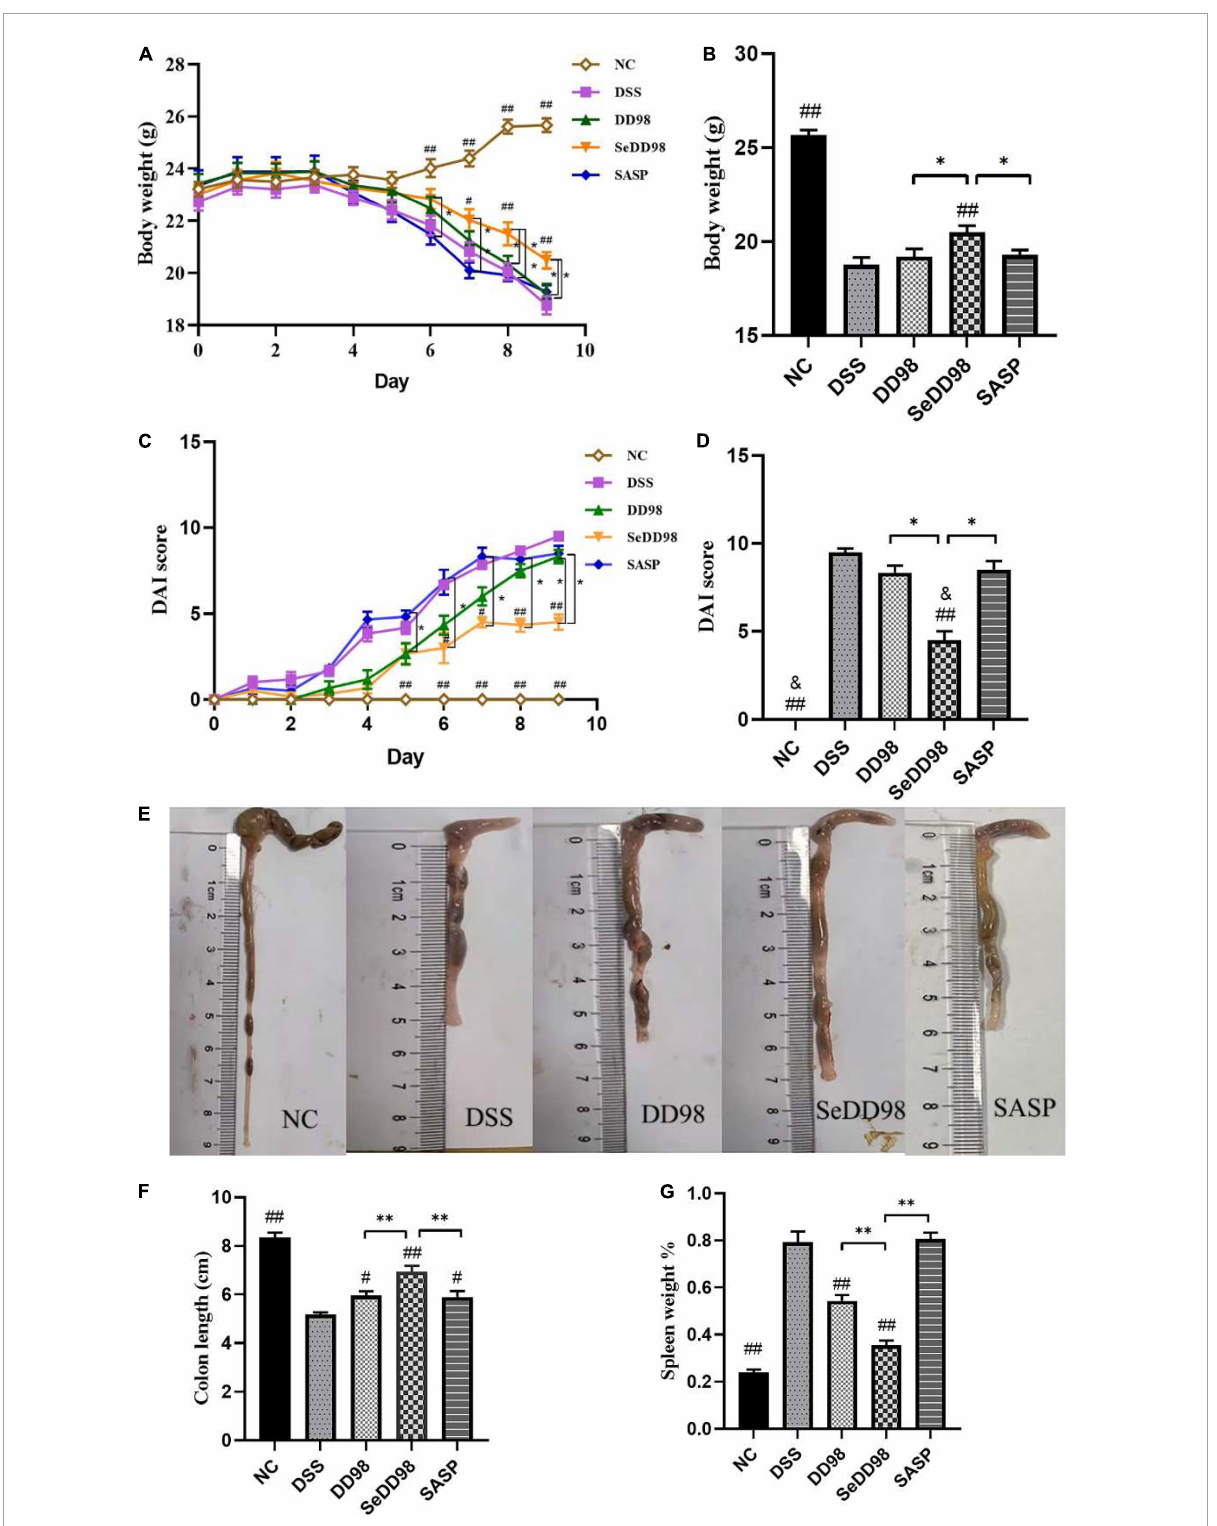
FIGURE2 Effects of Se- B. longum DD98 on colitis symptoms in mice ( n = 6). (A) Body weight change. (B) Body weight among the groups at day 9. (C) The disease activity index (DAI) scores calculated with time. (D) The DAI scores among the groups at day 9. (E) Representative images of colon tissues. (F) Data of the colon length. (G) The ratio of spleen weight to body weight. Data are shown as the mean ± SEM. ∗ p < 0.05, ∗∗ p < 0.01. # p < 0.05 compared to DSS group. ## p < 0.01 compared to DSS group. & p > 0.05 compared to NC group. Body weight, colon length, and the percentage of spleen weight were analyzed by one-way ANOVA. DAI score was analyzed by Kruskal–Wallis